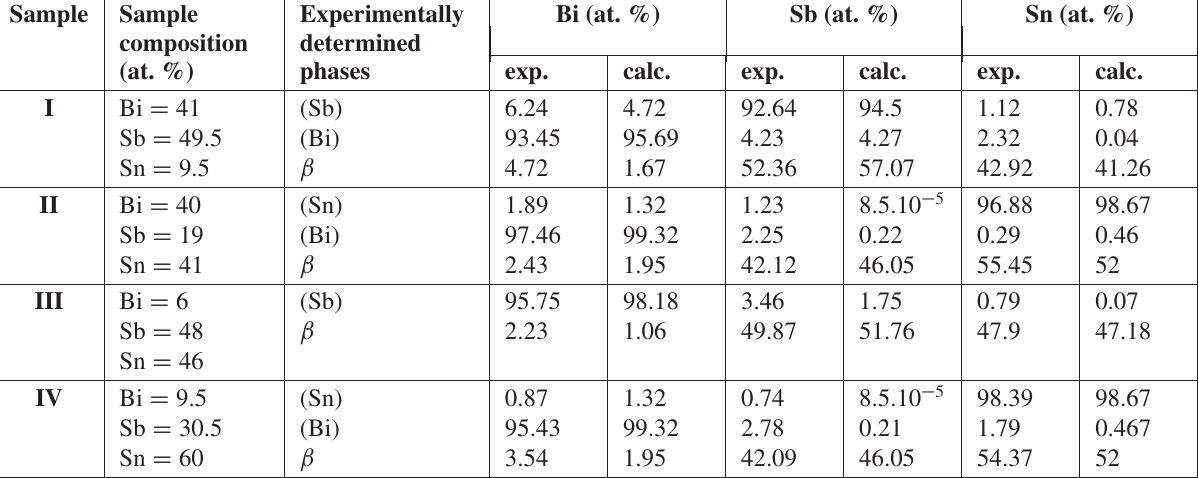
Table 3. Calculated and experimentally determined phase compositions in the ternary Bi-Sb-Sn system at 298 K. value of the greatest discrepancies was " max D 2:45926 and less than 3*E D 2:683942518 so based on the three (cid:2) rule,